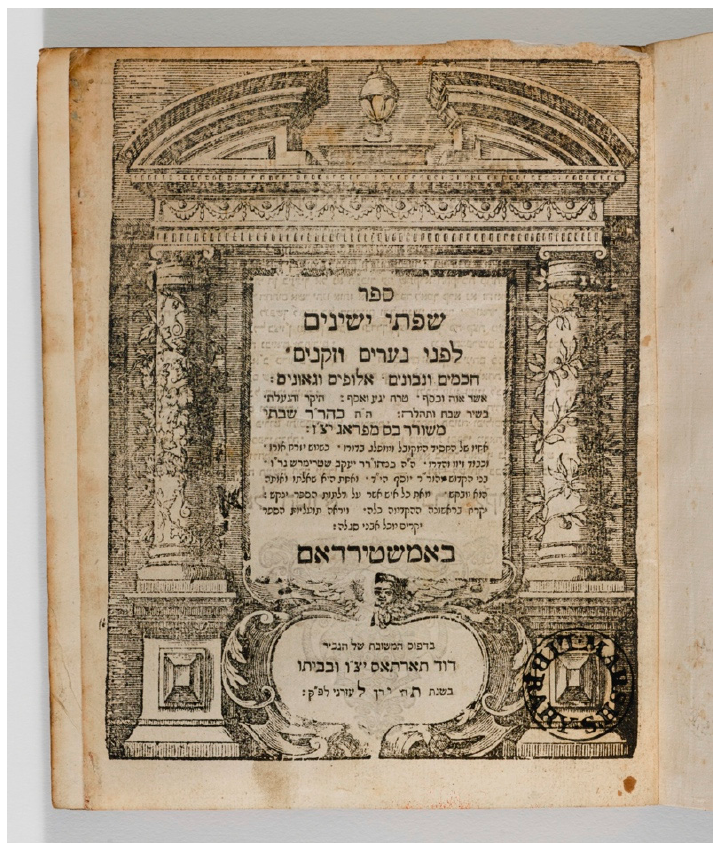
Figure 26. Sefer Sifte Yeshanim (Bibliographic work); Marsh’s Library B.3.4.11.